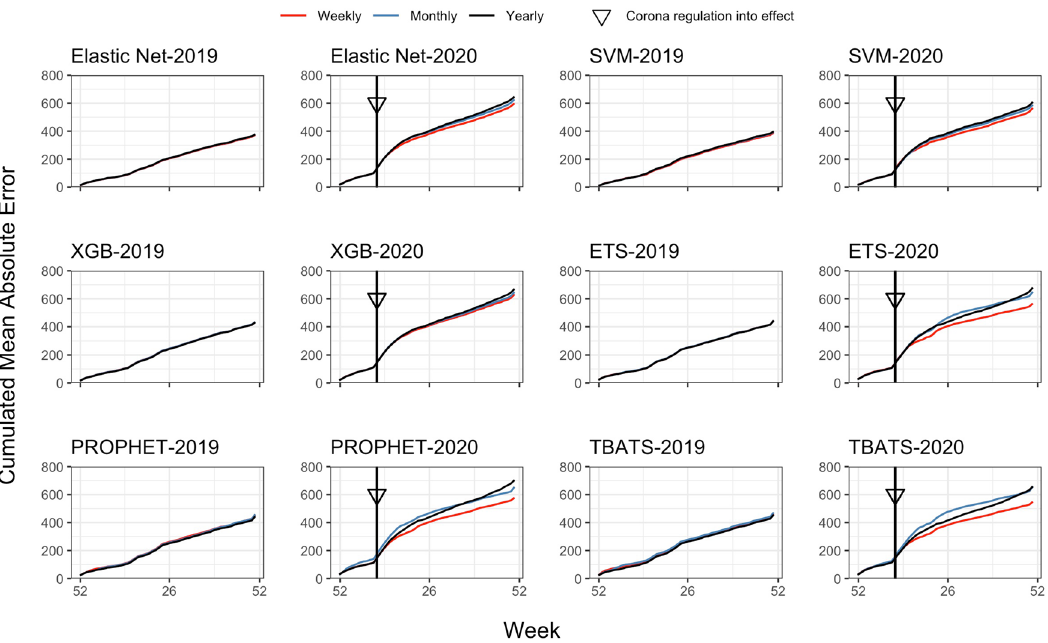
Figure 2. Cumulated mean absolute error in 2019 and 2020 by machine learning and time series models (days). XGB = Gradient boosting with trees, SVM = Support vector machines, ETS = Exponential smoothing state space models, TBATS = Exponential smoothing state space models with Box-Cox transformation, ARMA errors and trend and seasonal components, PROPHET = Additive models with non-linear trends fitted by seasonal